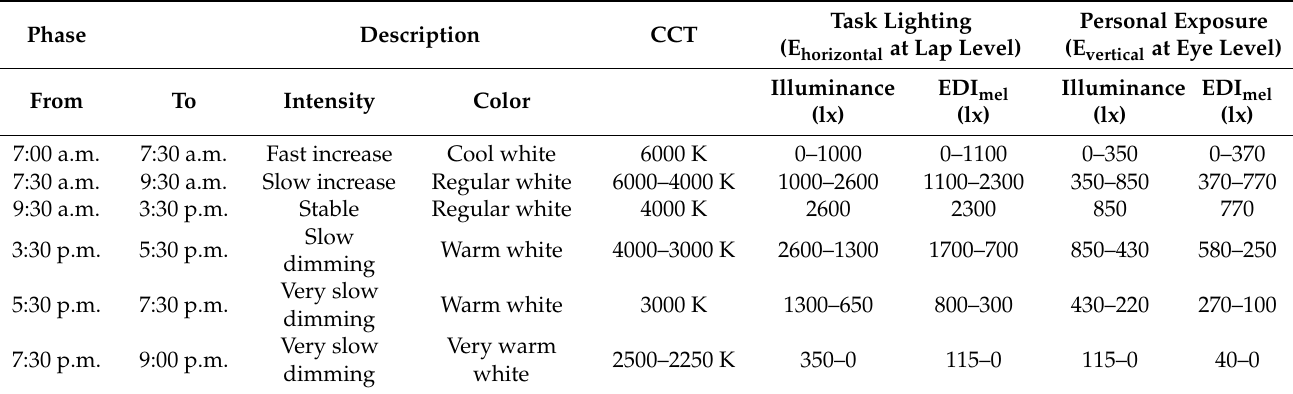
Note: Estimates based on measurements performed in a small white room without daylight, with a spectrometer fixed at the average estimated lap position to measure horizontal task illuminance and at the estimated eye position to measure vertical illuminance. This table reports the beginning and end states of dynamic phases. Numbers have been rounded off for